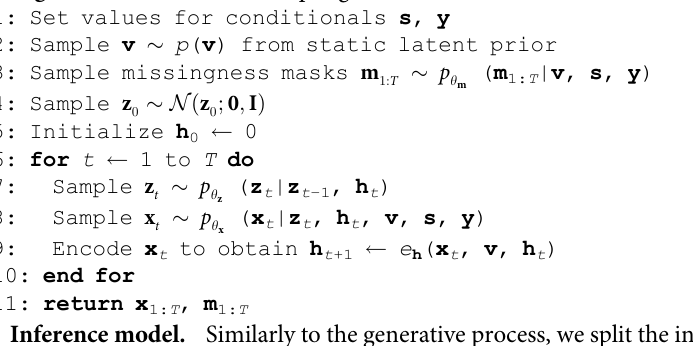
Algorithm 1 HealthGen